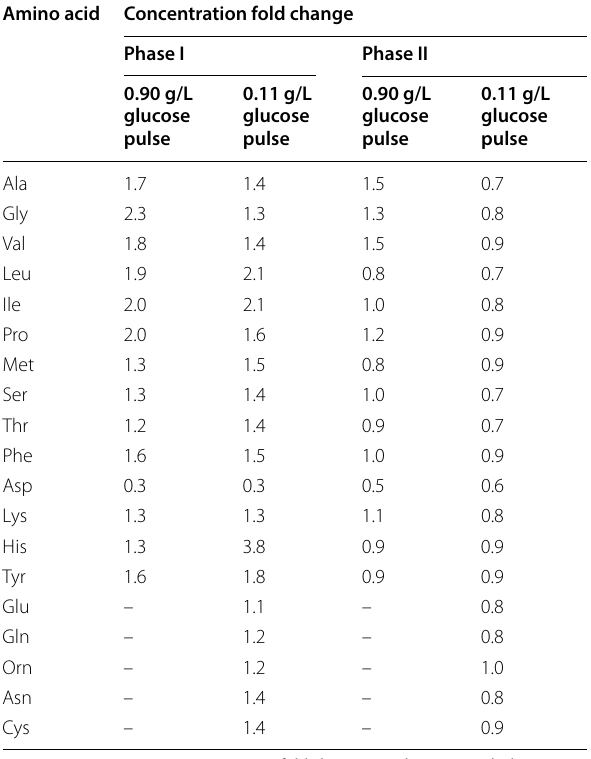
Table 5 Concentration fold change of amino acids in phase I and II